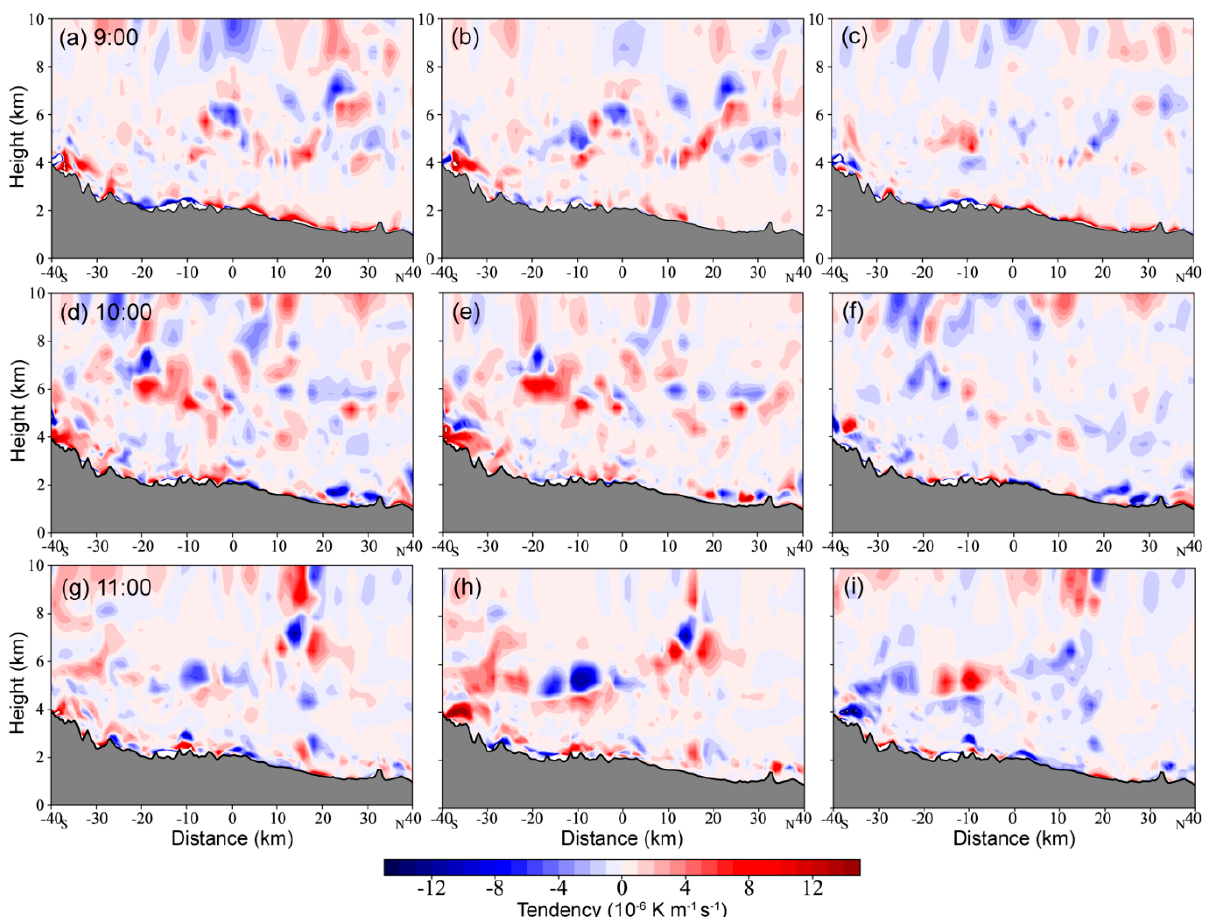
Figure 13. Modeled cross − section of ( a ) the tendency of convective stability, ( b ) the vertical wind shear term, and ( c ) the divergence term of the convective stability tendency at 9:00 UTC along the east black line in Figure 10. S and N below each panel indicate south and north of the cloud radar; ( d − f ) and ( g − i ) are the same as ( a − c ) but for 10:00 and 11:00 UTC, respectively.